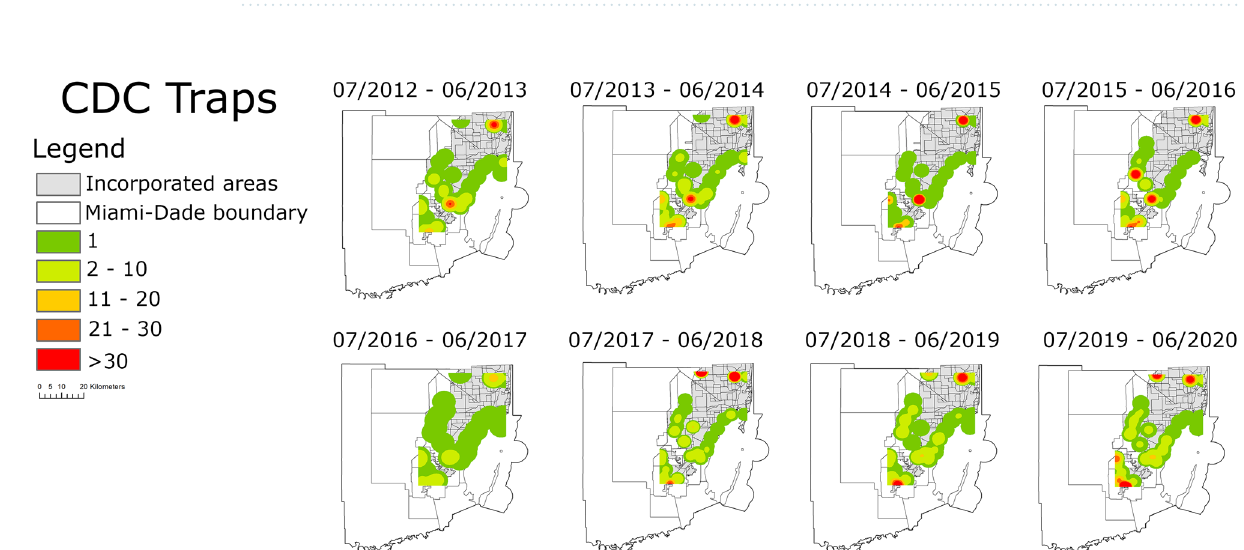
Table 2. Epidemiologically relevant mosquito vector species collected in the urban areas of Miami-Dade County, Florida from 2016 to 2020 by the BG-Sentinel traps.